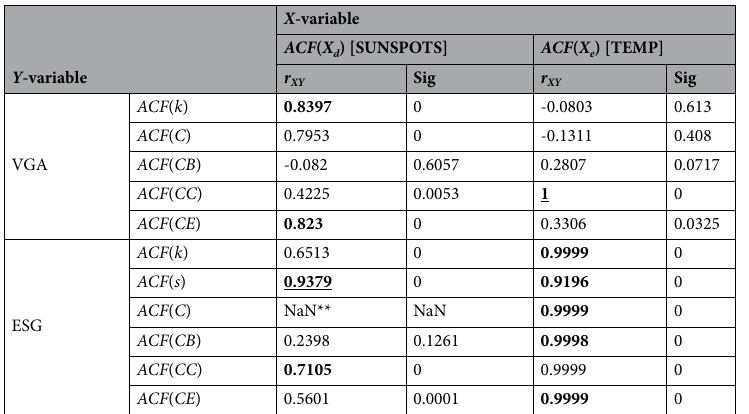
Table 5. Correlations of ACFs (*) between the source and the node-series (Sunspots and Temp). * ACF s are computed on lags from 1:30 (relation 13). **Not a number (unable to compute due to zero entries). Cases shown in bold indicate max coefficients (in absolute terms) according to pairwise (ESG vs . VGA) comparisons (only statistically significant cases are shown). Underlined cases indicate max coefficients (in absolute terms) within each column (for each time-series